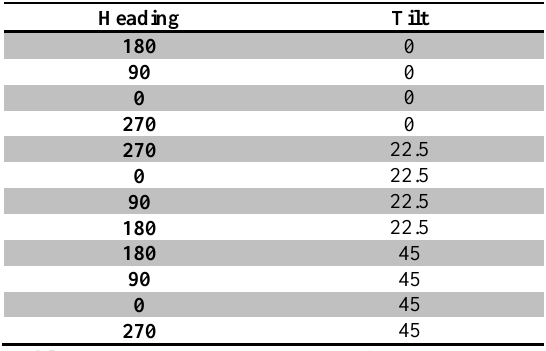
Table 2: Velodyne Sensor Orientation for 12 Point Clouds Collected at Each Observation Station